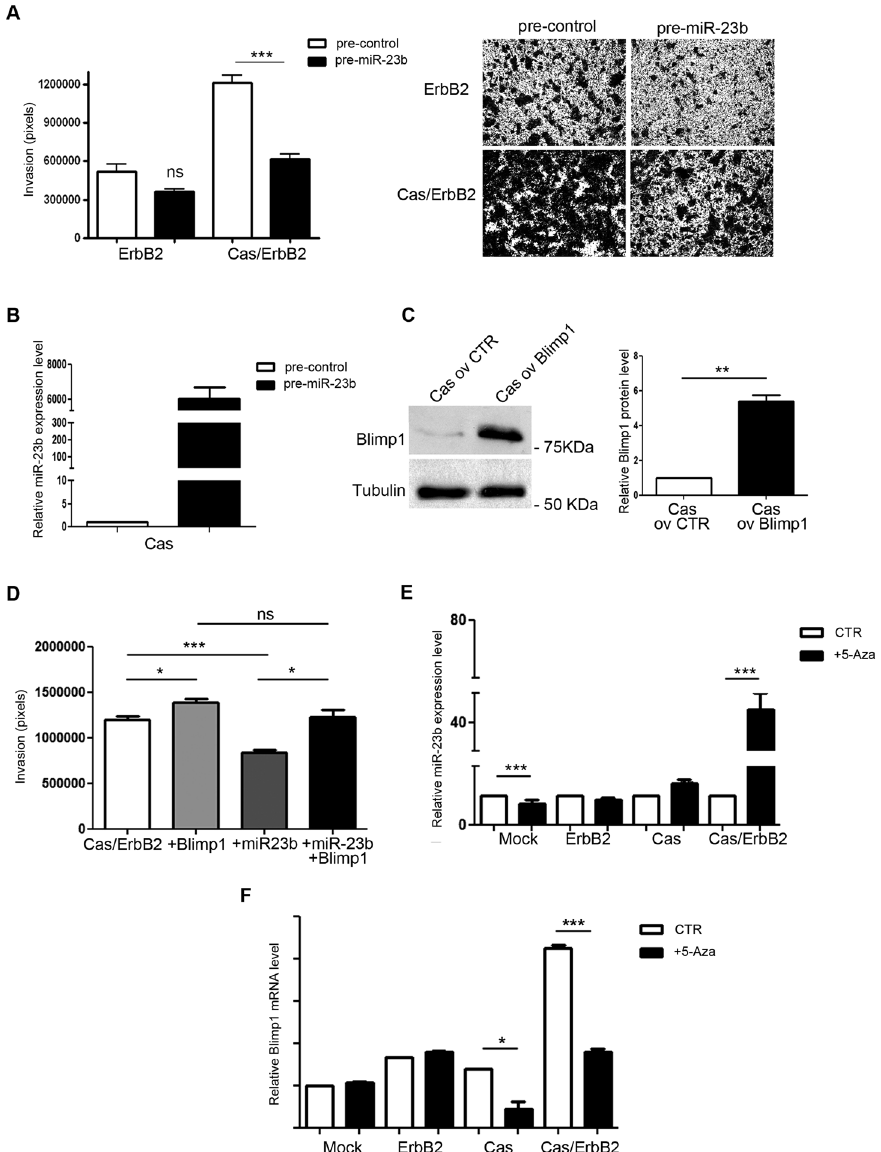
Figure 6. Blimp1 is a new negative target of miR-23b that impairs cell invasion. ( A ) MCF10A.B2 Mock and Cas cells 24 hours after transfection with either the miR-23b precursor (pre-miR-23b) or negative controls (pre- control) were subjected to transwell invasion assays for 48 hours in the presence of 1 µ M AP1510. Cell invasion quantification was performed across three different experiments. Results are presented as mean ± s.e.m. of the area covered by invaded cells. Representative images of invaded cells after 48 hours, fixed and stained with Crystal violet are reported ( *** p < 0.001). Magnification 5X. ( B ) qRT-PCR of miR-23b in MCF10A.B2 Cas cells showing the levels of miR-23b expression 48 hours after pre-miR-23b transfection (pre-miR-23b) as compared to control (pre-control) transfected cells. Results were calculated as fold changes (mean ± s.e.m.) relative to controls, normalized to U44 ( C ) MCF10A.B2 Cas cells overexpressing Blimp1 protein lacking its 3 ′ UTR were probed for Blimp1 in a western blot analysis. Tubulin was used as the loading control. Densitometric analyses of protein levels in at least three independent experiments are shown (mean ± s.e.m.). Statistical analyses were performed using the Student’s t-test ( ** p < 0.01). ( D ) MCF10A.B2 Cas/ErbB2 cells were subjected to transwell invasion assays for 48 hours. Cas/ErbB2 cells were either transduced to overexpress Blimp1 protein ( + Blimp1), transfected with the precursor miR-23b for 24 hours ( + miR-23b) or transduced to overexpress Blimp1 protein and transfected with the precursor of miR-23b contemporary ( + Blimp1, + miR-23b). Statistical analyses were performed at least on three independent experiments using the Student’s t-test ( * p < 0.05, *** p < 0.001). ( E ) qRT-PCR of miR-23b after treatment of MCF10A.B2 Mock, ErbB2, Cas, Cas/ErbB2 cells with 10 µ M 5-Aza or DMSO for 48 hours. Results were calculated as fold changes (mean ± s.e.m.) relative to controls, normalized to U44 ( *** p < 0.001). ( F ) qRT-PCR of Blimp1 after treatment of MCF10A.B2 Mock, ErbB2, Cas, Cas/ErbB2 cells with 10 µ M 5-Aza or DMSO for 48 hours. Results were calculated as fold changes (mean ± s.e.m.) relative to controls, normalized to 18S ( * p < 0.05, *** p <